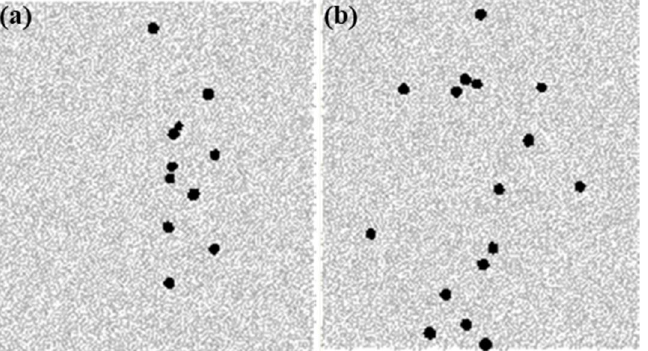
Figure 20. Simulation results of the distribution of soybean seed particles on the soil tray at relative seed throwing speeds of ( a ) 0.57 m/s and ( b ) 1.57 m/s.